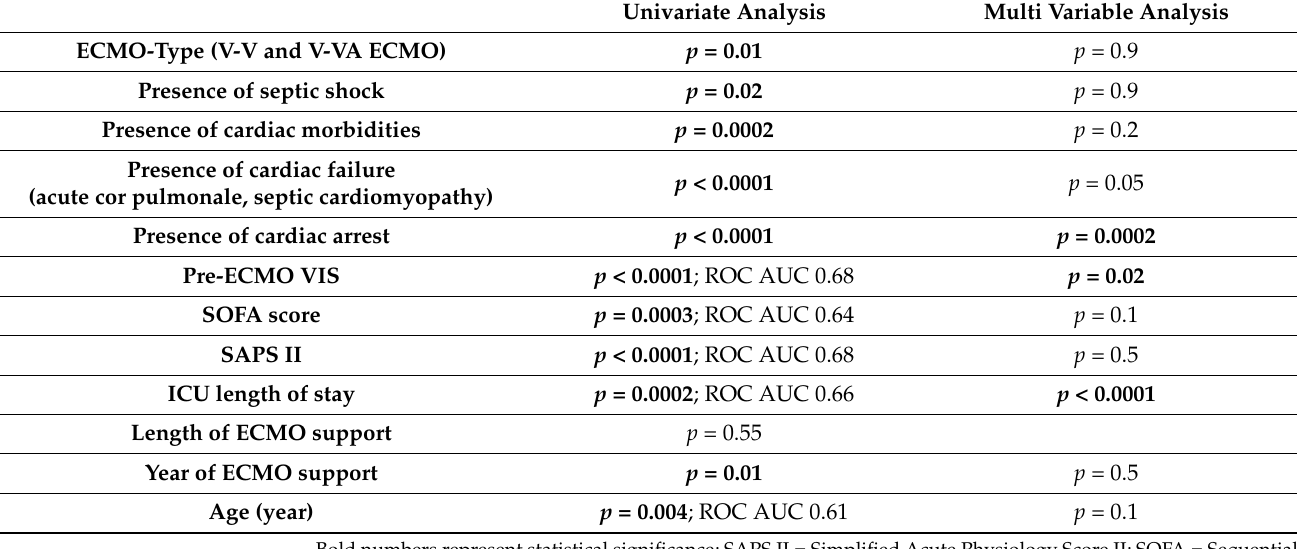
Table 3. Factors affecting overall ICU mortality in univariate and multi-variable analyses. Univariate Analysis